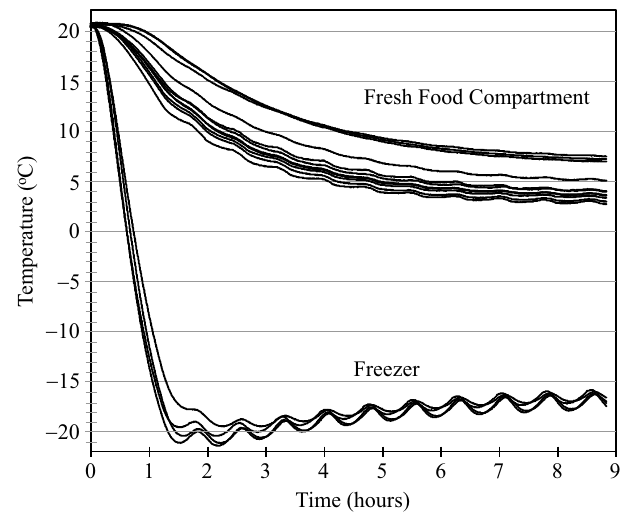
Figure 3. Temperature as a function of